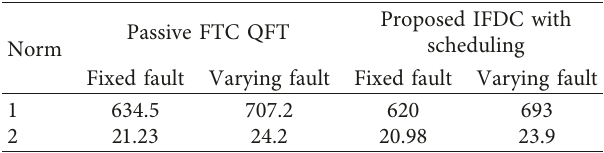
Figure 11: Control envelope for the time-varying fault case using the passive FTC and the proposed scheduling design. Table 1: Comparison of norms of control efforts with the passive FTC and the proposed